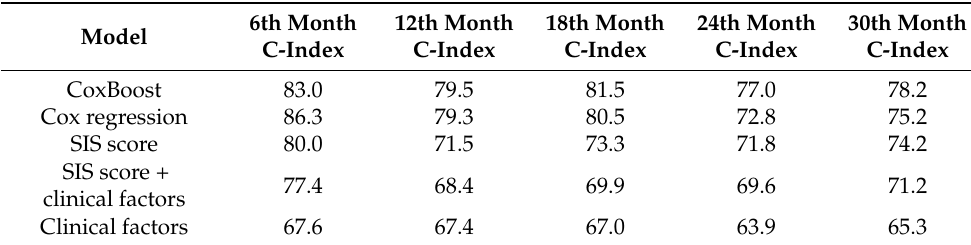
Figure 4. The concordance index for each model in testing dataset every month. After 22nd month in follow-up, compared to other models (Cox regression, SIS score, SIS score + clinical factors, and clinical factors), the C-index of ML model for prediction of the MACE in the testing dataset was significantly increased (C-index: 0.770–0.782, 0.723–0.752, 0.706–0.742, 0.786–0.712, 0.639–0.653, p < 0.05). Table 3. The performance (concordance-index) for each model validated at each half year of follow-up.